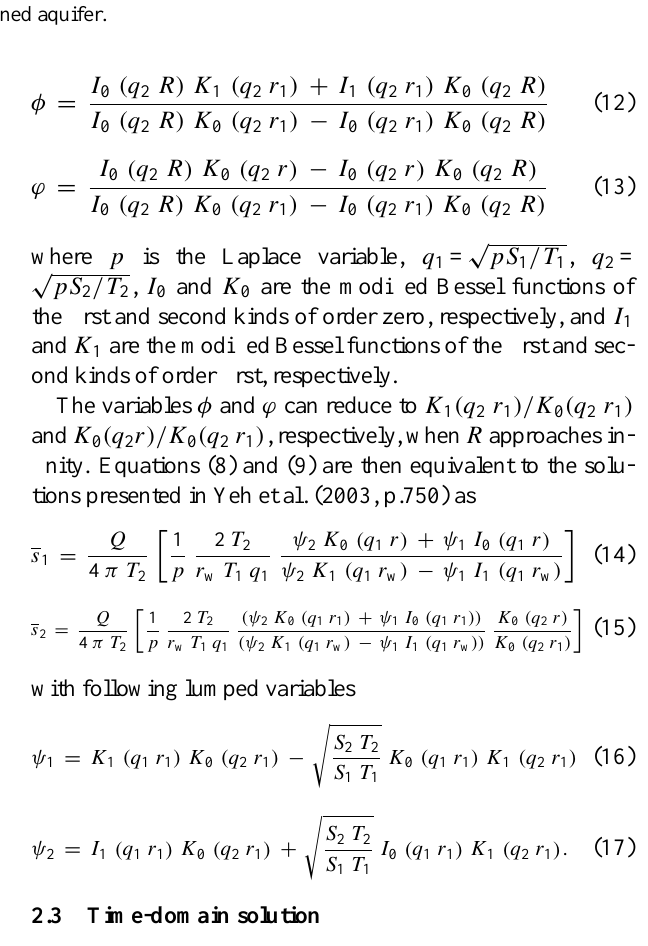
Fig. 1. Schematic diagram of the pumping test in a finite-extent confined aquifer.